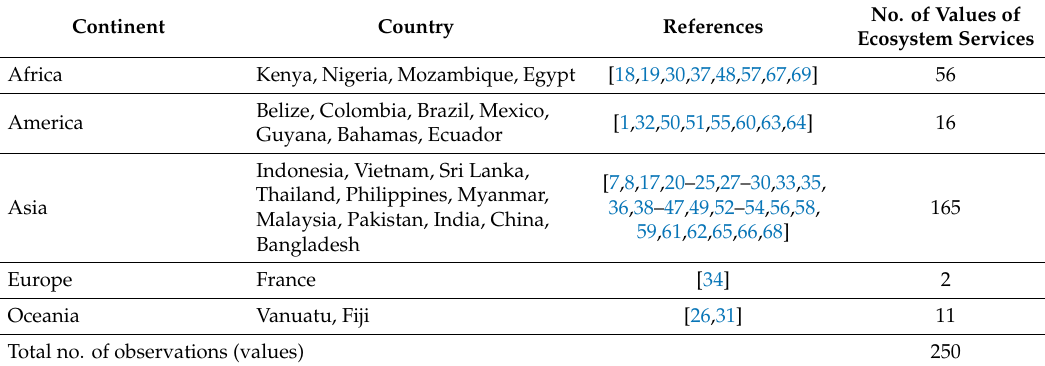
Table 1. Distribution of the values of ecosystem services included in the database.